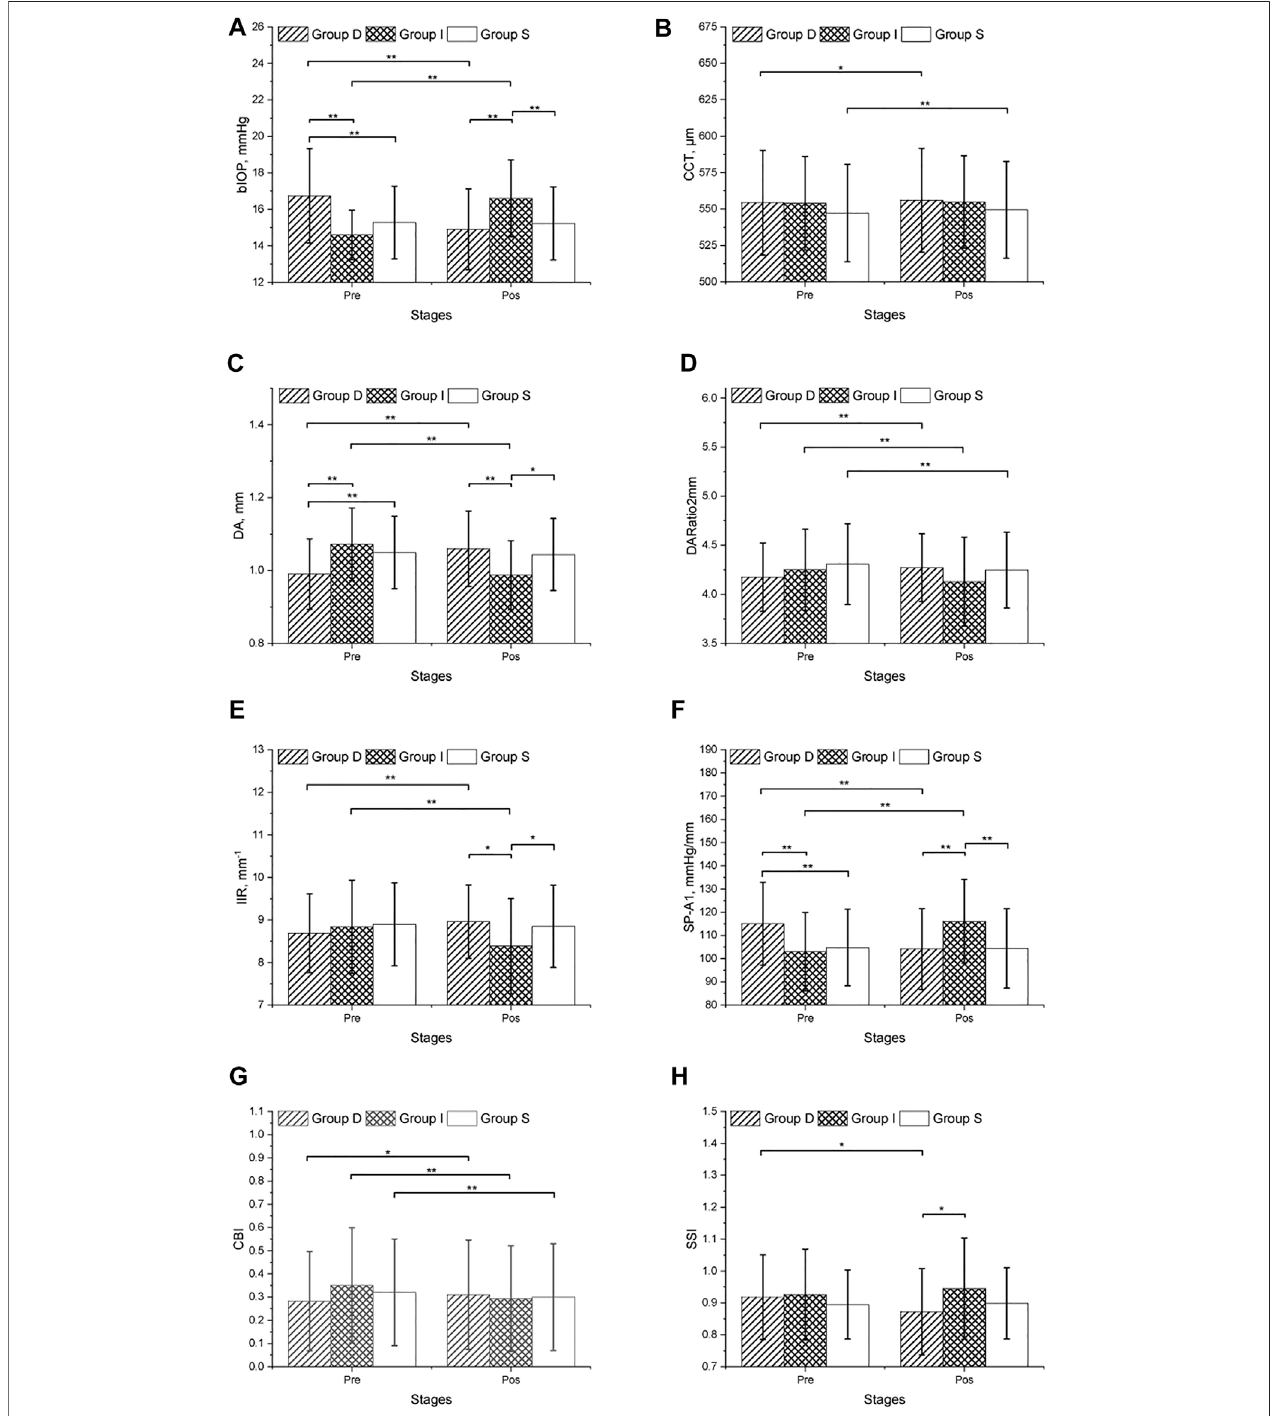
FIGURE 1 | CVS metrics collected before and after the mydriasis test in three groups.